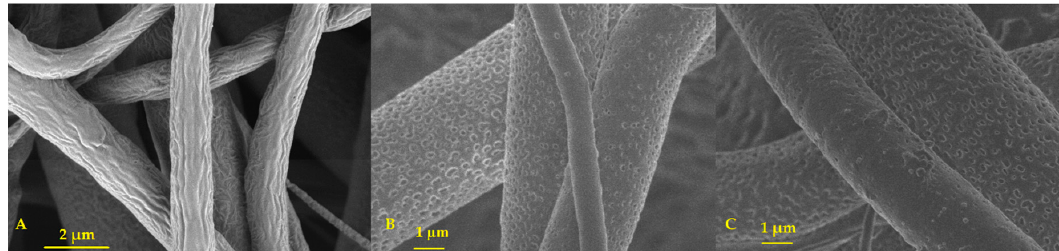
Figure 3. SEM images of ( a ) PCL, ( b ) PCL/PVP 85:15 and ( c ) PCL/PVP 95:5 microfibers scaffold after 7 days of physiological solution contact. All micrographs are 10,000× amplification (scale bar = 2 µm; scale bar = 1 µm for b and c).